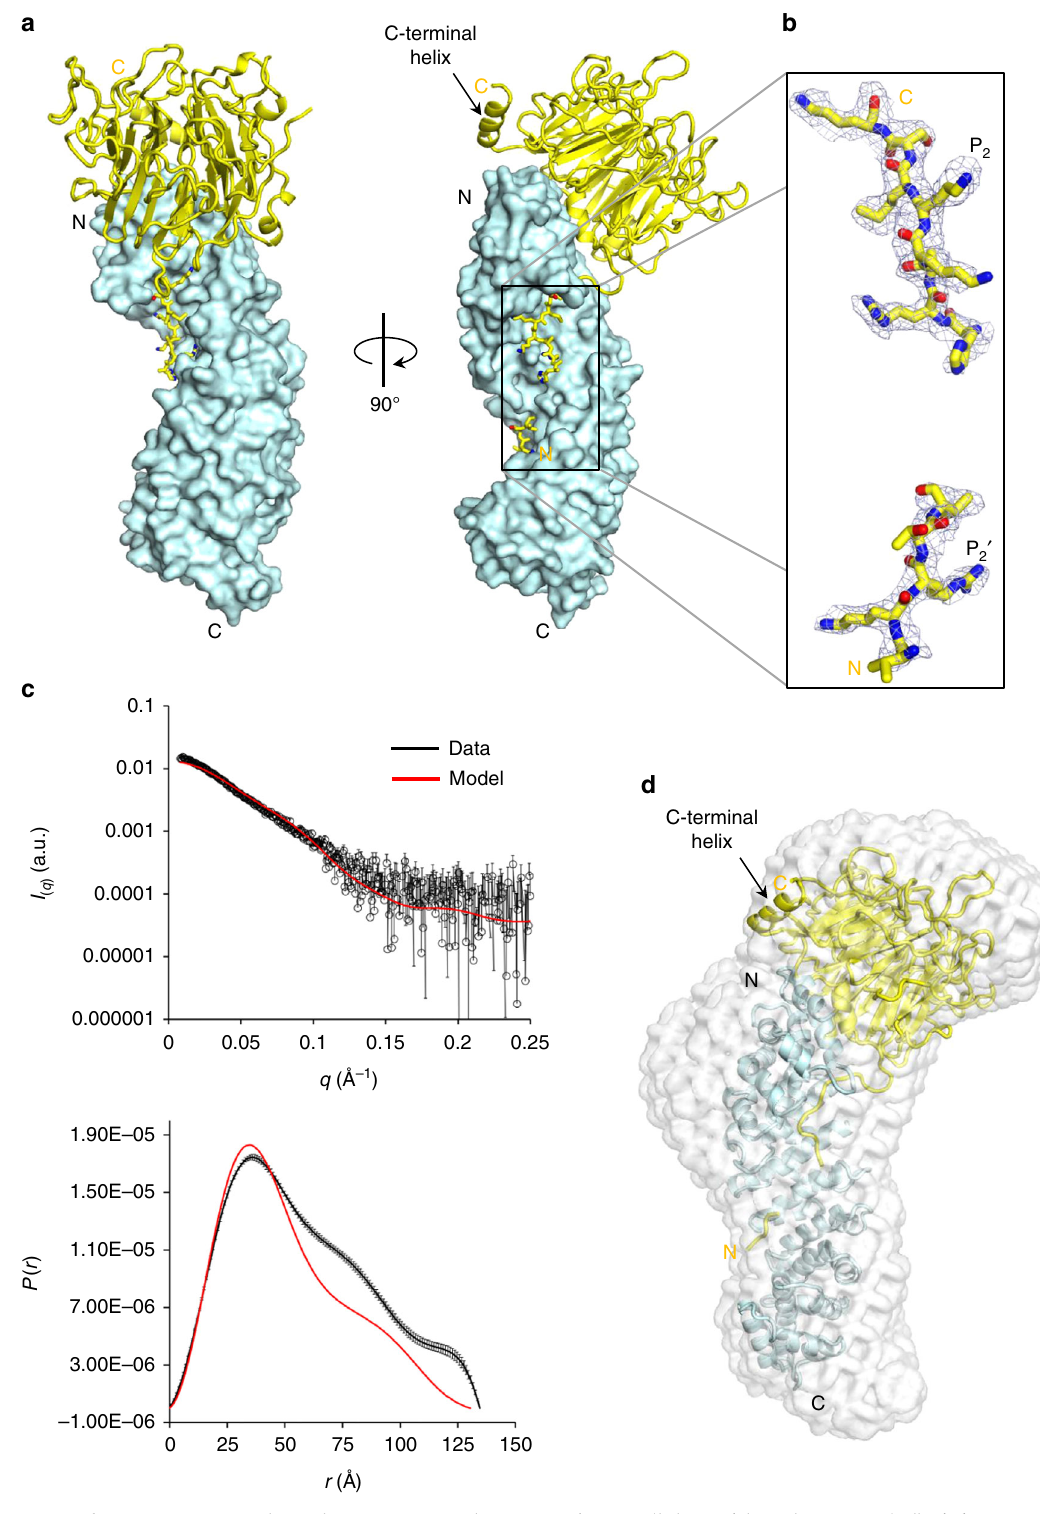
Fig. 6 The structure of yeast RCC1 in complex with Kap60. a Crystal structure of Kap60 ( light cyan ) bound to yRCC1 ( yellow ). b A representative F o − F c electron density difference map of yRCC1 N-terminal tail (in blue ) is displayed at 2 σ above background and is overlaid to the fi nal re fi ned model (residues 2 – 6 and 16 – 23) colored in yellow . c Average SEC-SAXS data calculated from frames 710 to 750 ( top panel ) and corresponding P ( r ) function ( bottom panel ) are shown in black. Scattering data and P ( r ) function calculated from the crystal structure of the Kap60:yRCC1 complex are shown in red . d Ab initio SAXS reconstructions of the Kap60:yRCC1 complex calculated from experimental scattering values obtained from SEC-SAXS (frames 710 – 750). The crystallographic structure of the complex is overlaid to the SAXS